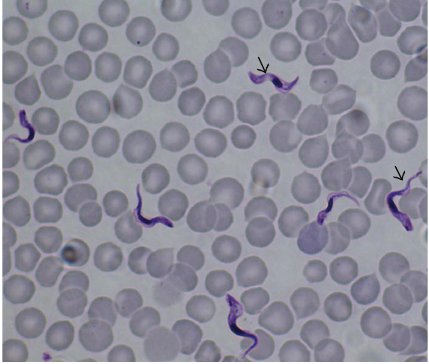
Figure 1: Show detection of Trypanosoma congolense (arrow) in greater kudu ( Tragelaphus strepsiceros